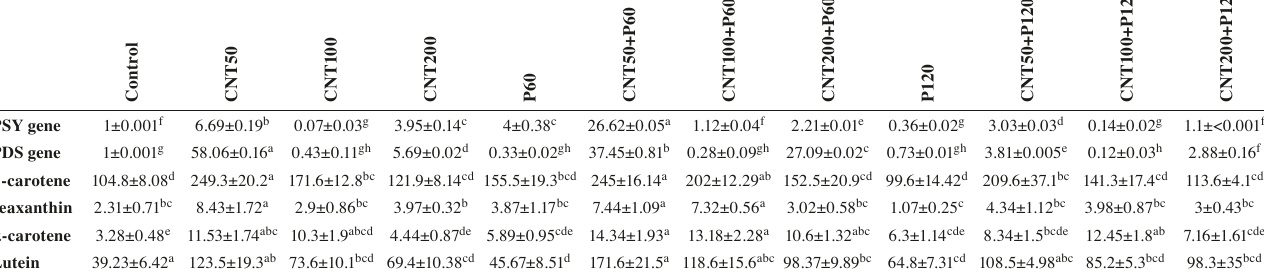
Tab. 4: Evaluation of PSY and PDS genes expression and carotenoid content ( μg g -1 dry weight). Results expressed as mean ±SD (n=3) in different plasma and CNT treated groups of M. charantia *.